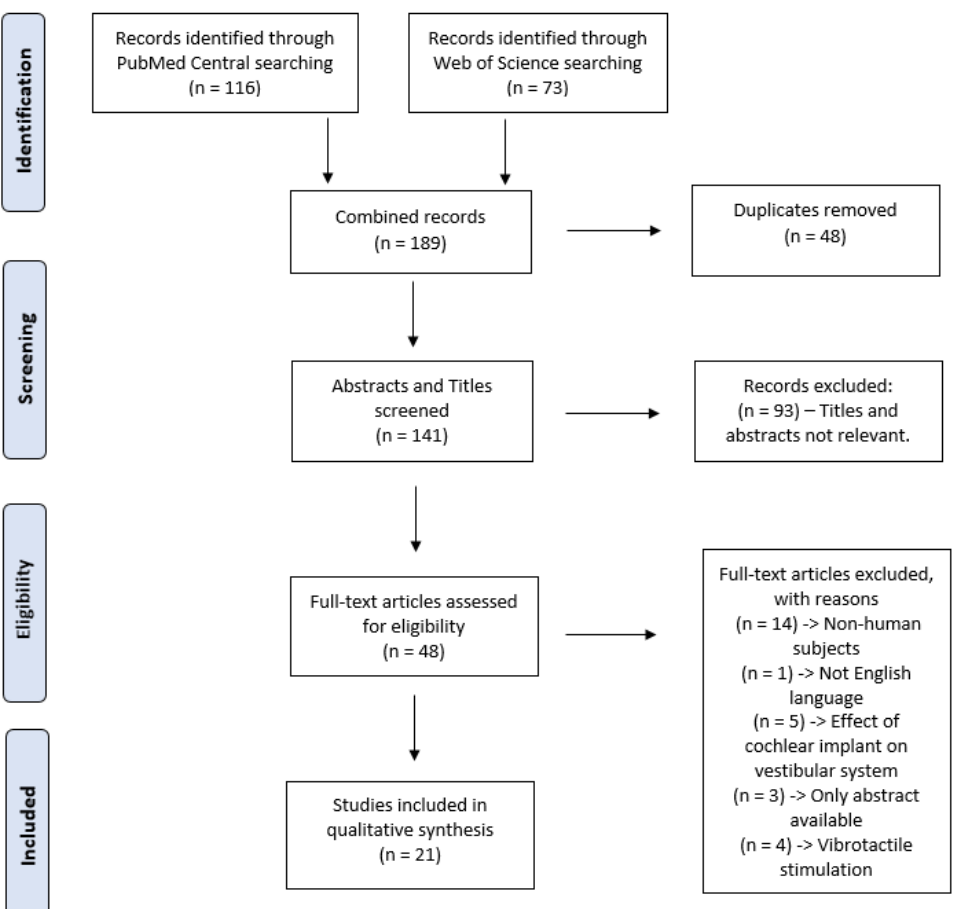
Figure 1. The PRISMA flowchart representing the study selection process.